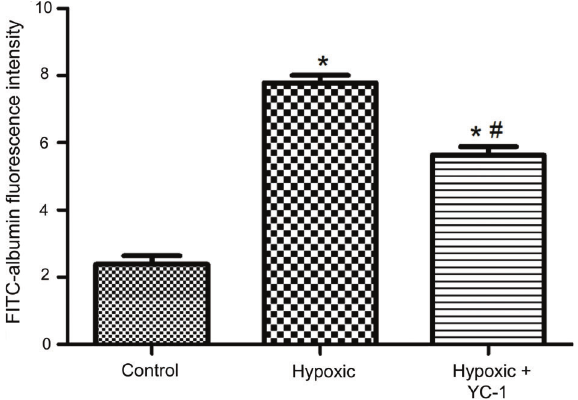
Figure 3. Effect of YC-1 on increased bladder cancer cell per- meability by hypoxia. Data are reported as means ± SD. *P o 0.05 compared with normal control group; # P o 0.05 compared with hypoxic group (ANOVA). Time of incubation with YC-1=48